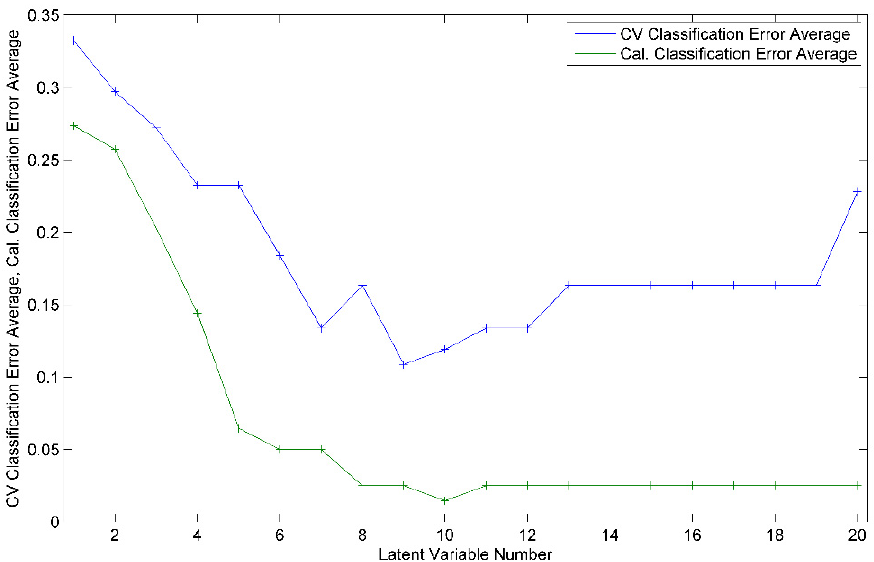
Figure 11. Cross-validation (CV) and calibration (Cal.) classification error average as function of the number of latent variables used to construct the PLS-DA model for the geographical differentiation of honey.